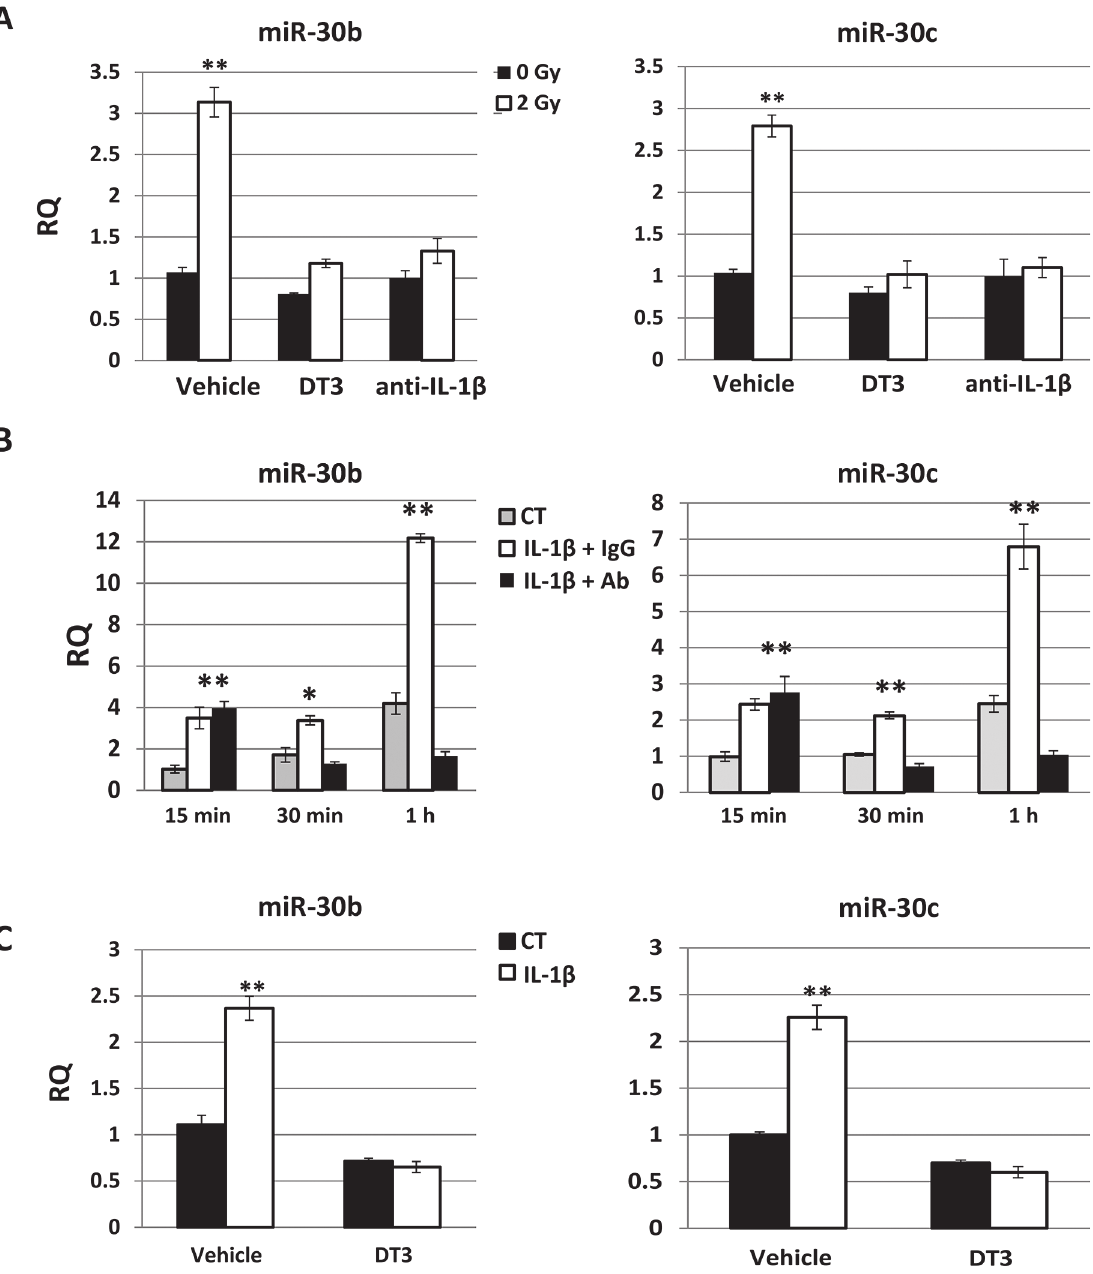
Fig 5. DT3 or anti-IL-1 β antibody suppressed radiation-induced miR-30 expression in CD34+ cells. (A) Vehicle, DT3, or neutralizing antibody for IL-1 β activation were added into CD34+ cell culture before 2 Gy radiation, and miR-30b and miR-30c expression were examined 1 h after irradiation. RQ = relative quantitation; ** p < 0.01; mean ± SD, 0 Gy vs. 2 Gy. (B) IL-1 β (10 ng/mL) was added to CD34+ culture with anti-IL-1 β antibody or nonspecific IgG control, and miR-30b and miR-30c expression were tested at 15 min, 30 min, and 1 h after addition of IL-1 β . IL-1 β significantly induced both miR-30b and miR-30c expression in CD34+ cells at all-time points. ** p < 0.01; mean ± SD, IL-1 β +IgG-treated or IL-1 β + anti-IL-1 β vs. vehicle-treated control. (C) Vehicle or DT3 was added to CD34+ culture 22 h before IL-1 β treatment, and miR-30 expression was examined at 24 h after DT3 addition and 1 h after IL-1 β treatment. DT3 administration abolished IL-1 β -induced miR-30 expression in CD34+ cells. ** p < 0.01; mean ± SD, DT3-treated vs. vehicle-treated controls. Results were from total three experiments.